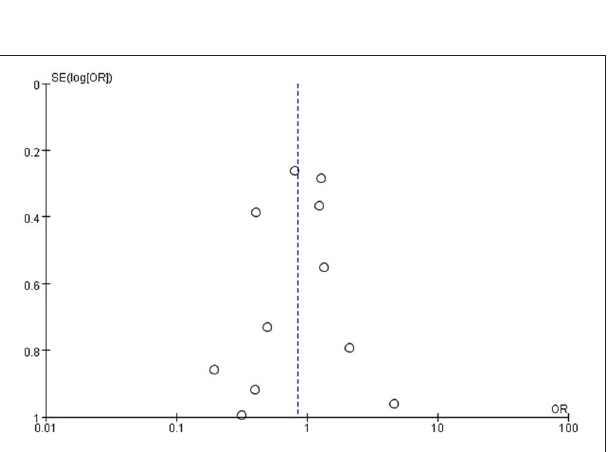
FIGURE 3 | Funnel plots for detecting publication bias in the primary outcome of reinfection